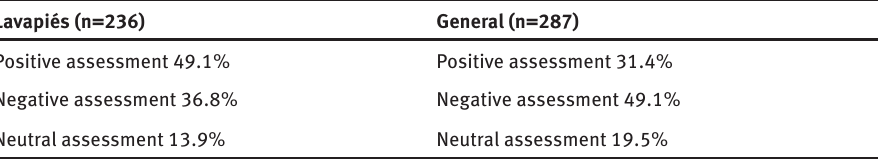
Table 2: Corpora Lavapiés (n=236) General (n=287) Positive assessment